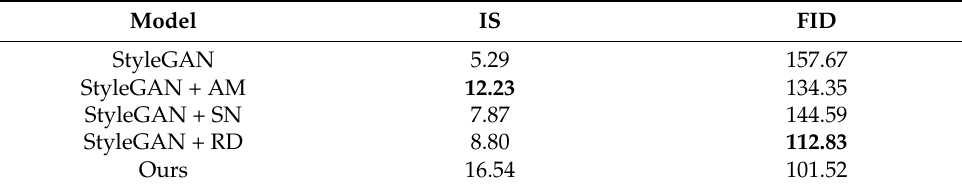
Table 2. Quantitative evaluation according to IS and